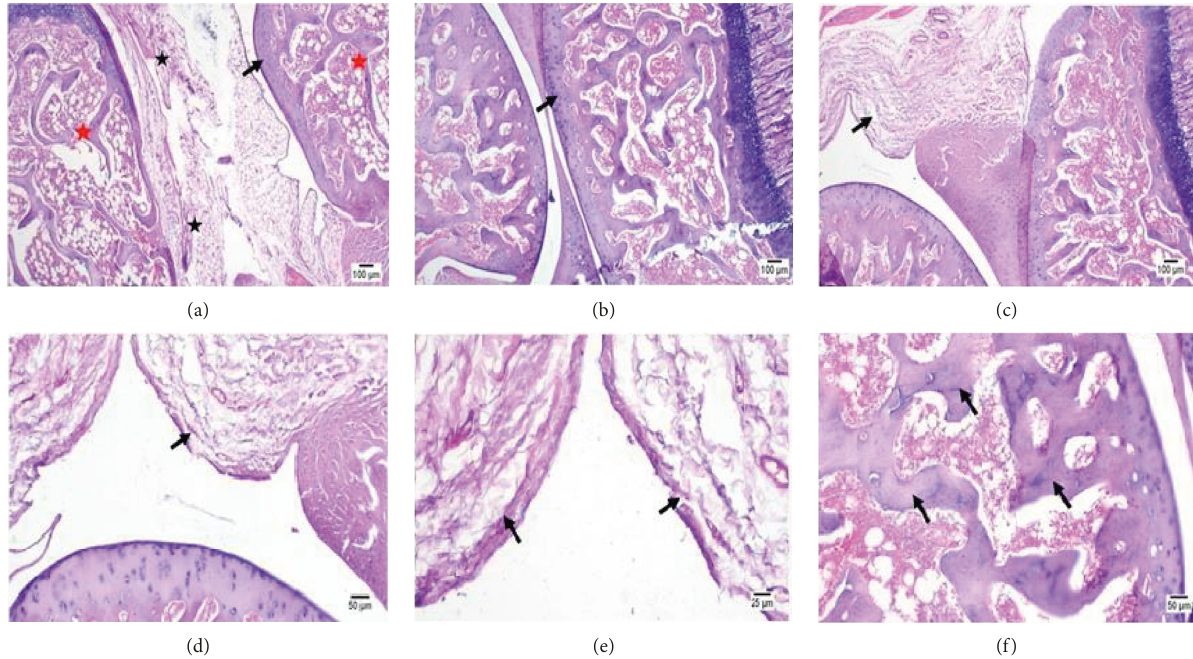
Figure 5: (a) Negative control group showing normal cartilage (black arrow), normal synovium (black star), and bone (red star); (b) higher magnification showing normal cartilage (black arrow); (c) normal synovial membrane and joint capsule (black arrow); (d) higher magnification showing synovial membrane and joint capsule (black arrow); (e) magnification showing synovial membrane and joint capsule (black arrows); and (f) normal trabecular bone (arrows) of the head of the bone.